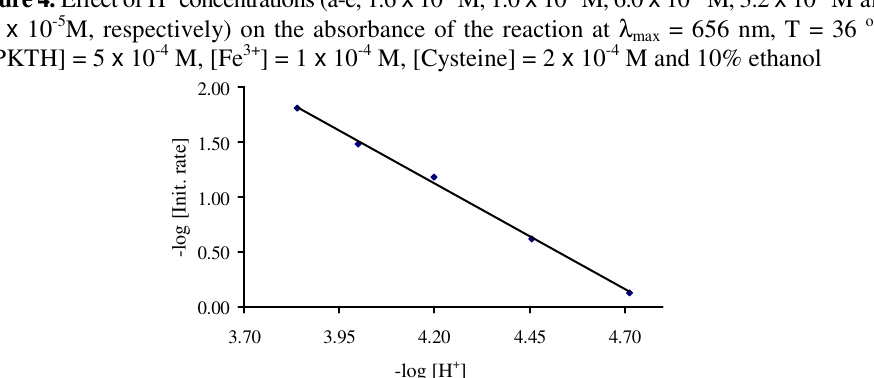
= 656 nm, T = 36 o C, max